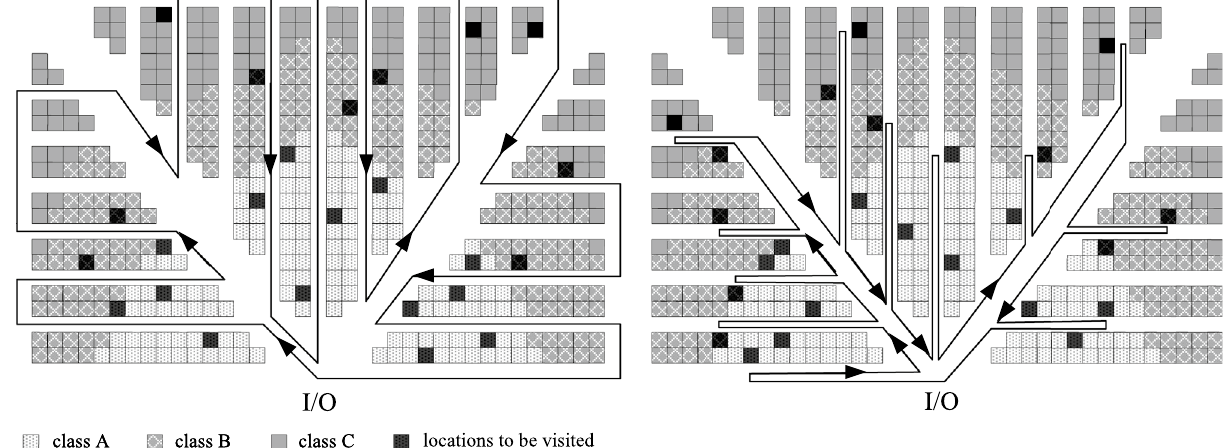
Figure 2. S-shape and return routing strategies in the fishbone layout warehouse under the class-based storage strategy (created with Microsoft Visio Professional 2019, 16.0.14827.20216, https:// www. micro soft. com/ en- gb/ micro soft- 365/ visio/ flowc hart- softw